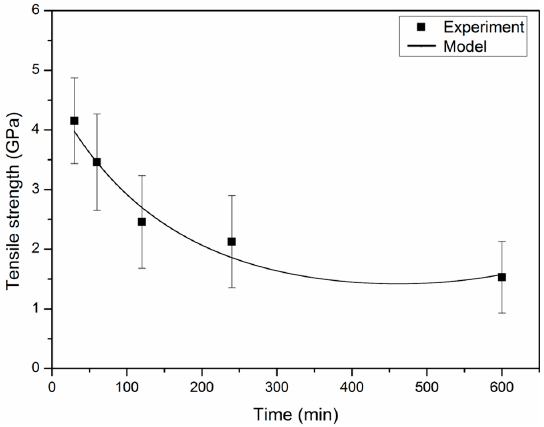
Figure 22. The dependence of the exposure time on the tensile strength.